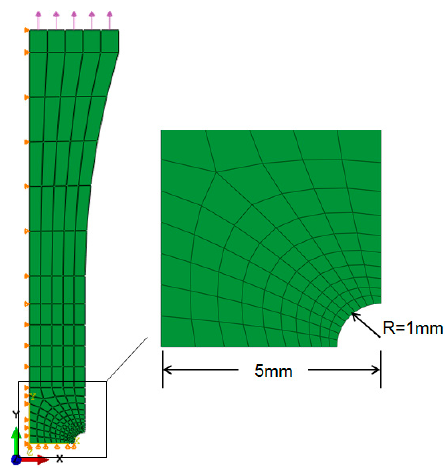
Figure 6. Axi-symmetrical finite element model of the notched bar.